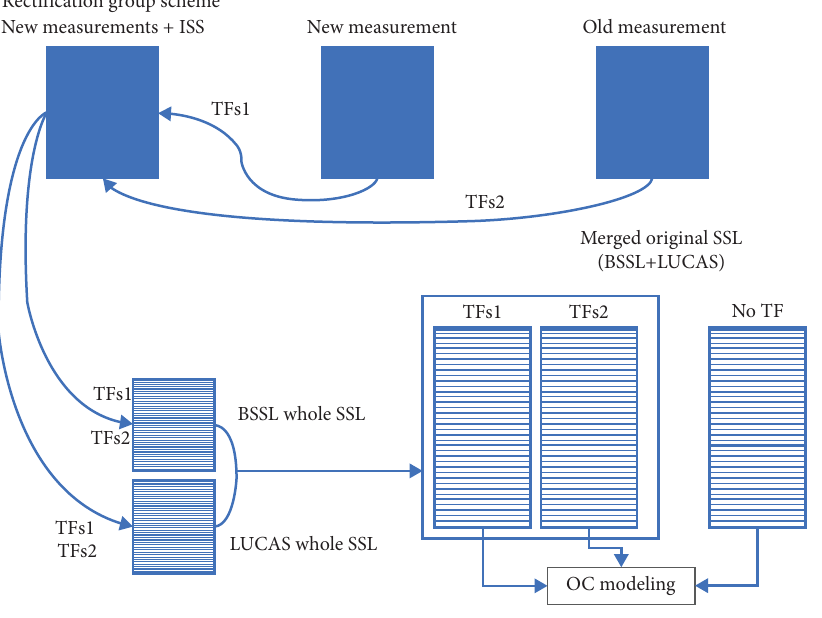
Figure 1: Rectifcation group